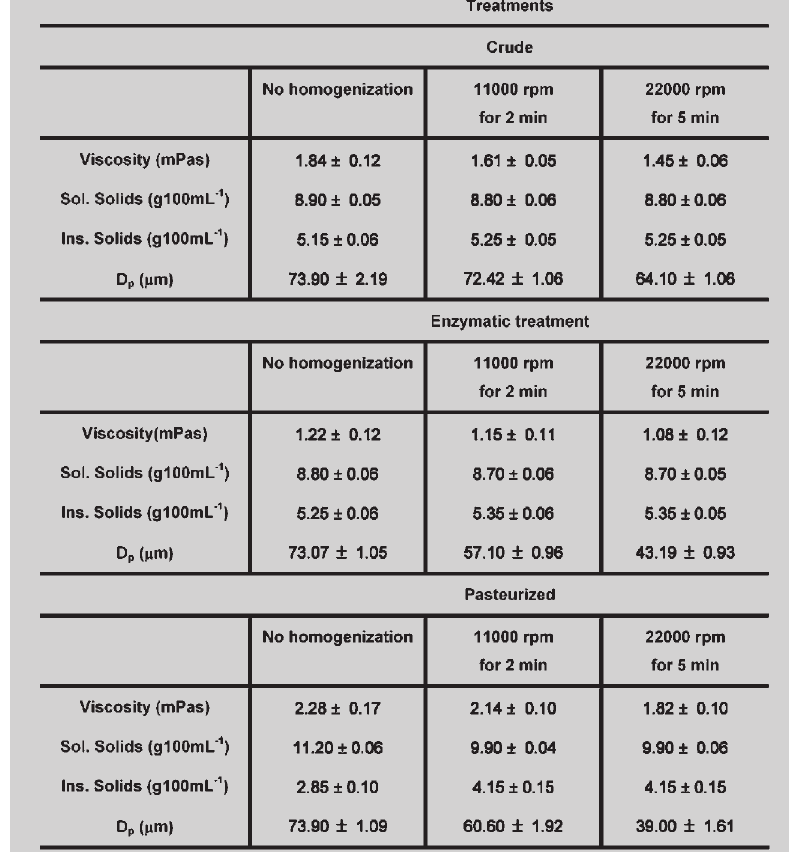
Rheological behavior of the pasteurized and homogenized